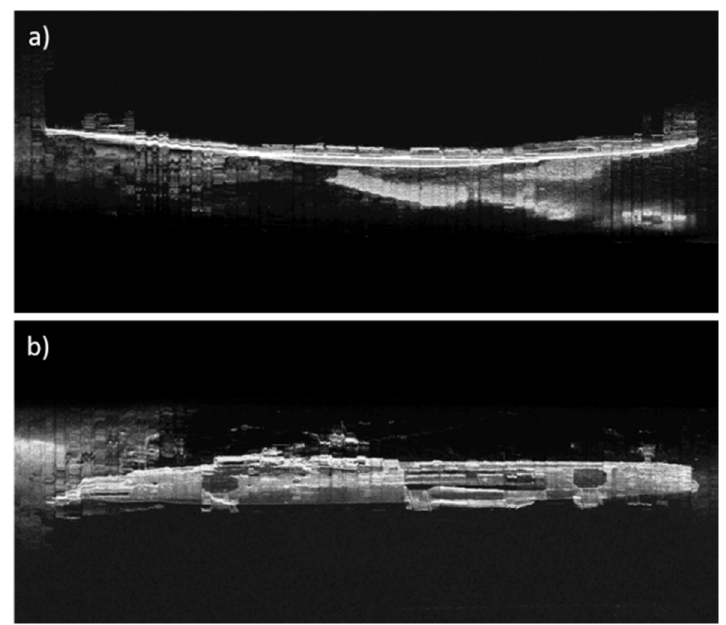
Figure 16. Sonograms acquired with a towed side-scan sonar DF-1000: ( a ) using operational parameters R = 150 m; Fa = 34 m; D = 75 m; ( b ) using operational parameters R = 150 m; Fa = 39 m; D = 75 m.